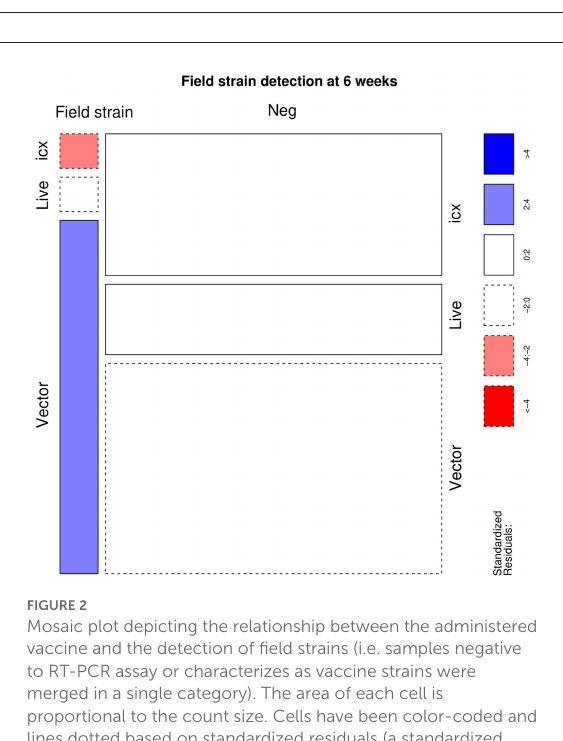
FIGURE2 Mosaic plot depicting the relationship between the administered vaccine and the detection of field strains (i.e. samples negative to RT-PCR assay or characterizes as vaccine strains were merged in a single category). The area of each cell is proportional to the count size. Cells have been color-coded and lines dotted based on standardized residuals (a standardized residual > 2 or < -2 is indicative of statistical